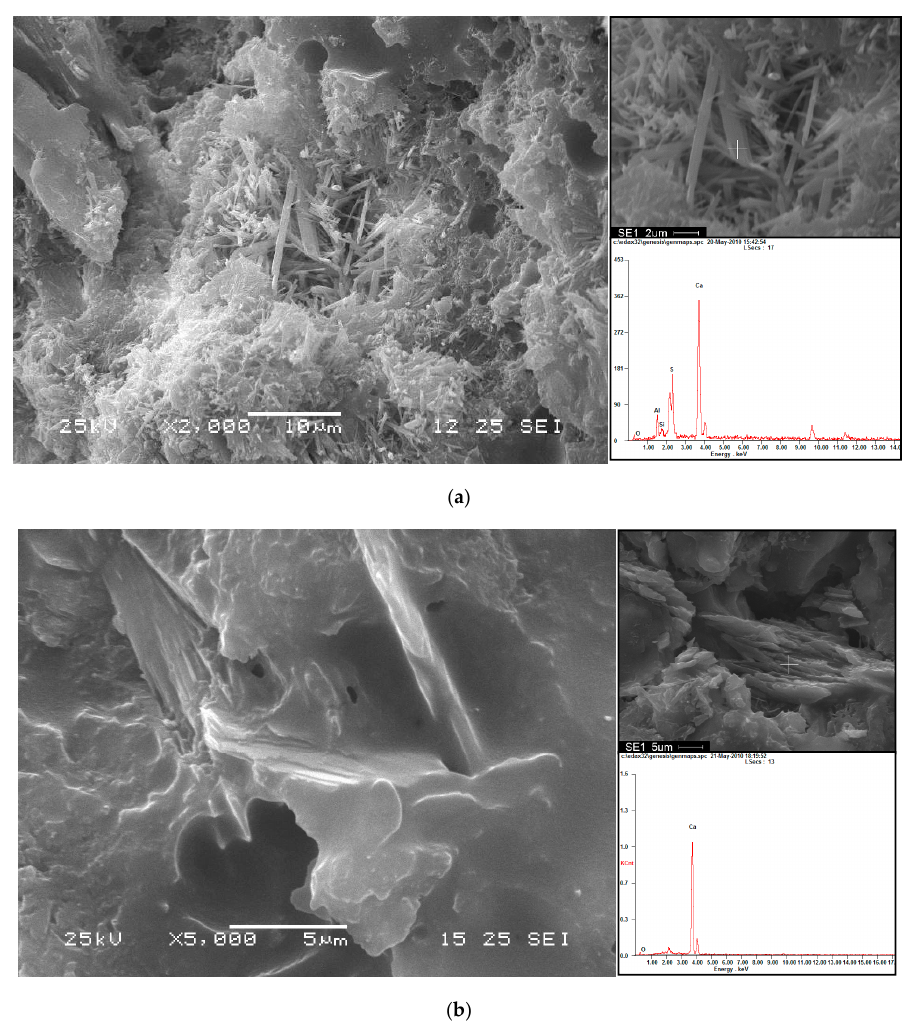
Figure 13. SEM and EDS analysis of CAM-I hydrated in different temperature (a) 20 °C, ( b ) 55 °C (hydration for 10 days).